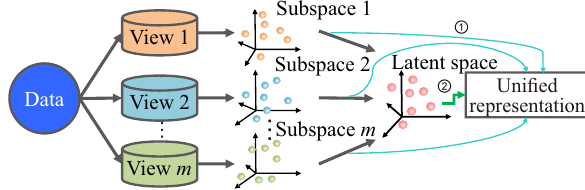
Fig. 9 General procedure of multi-view subspace